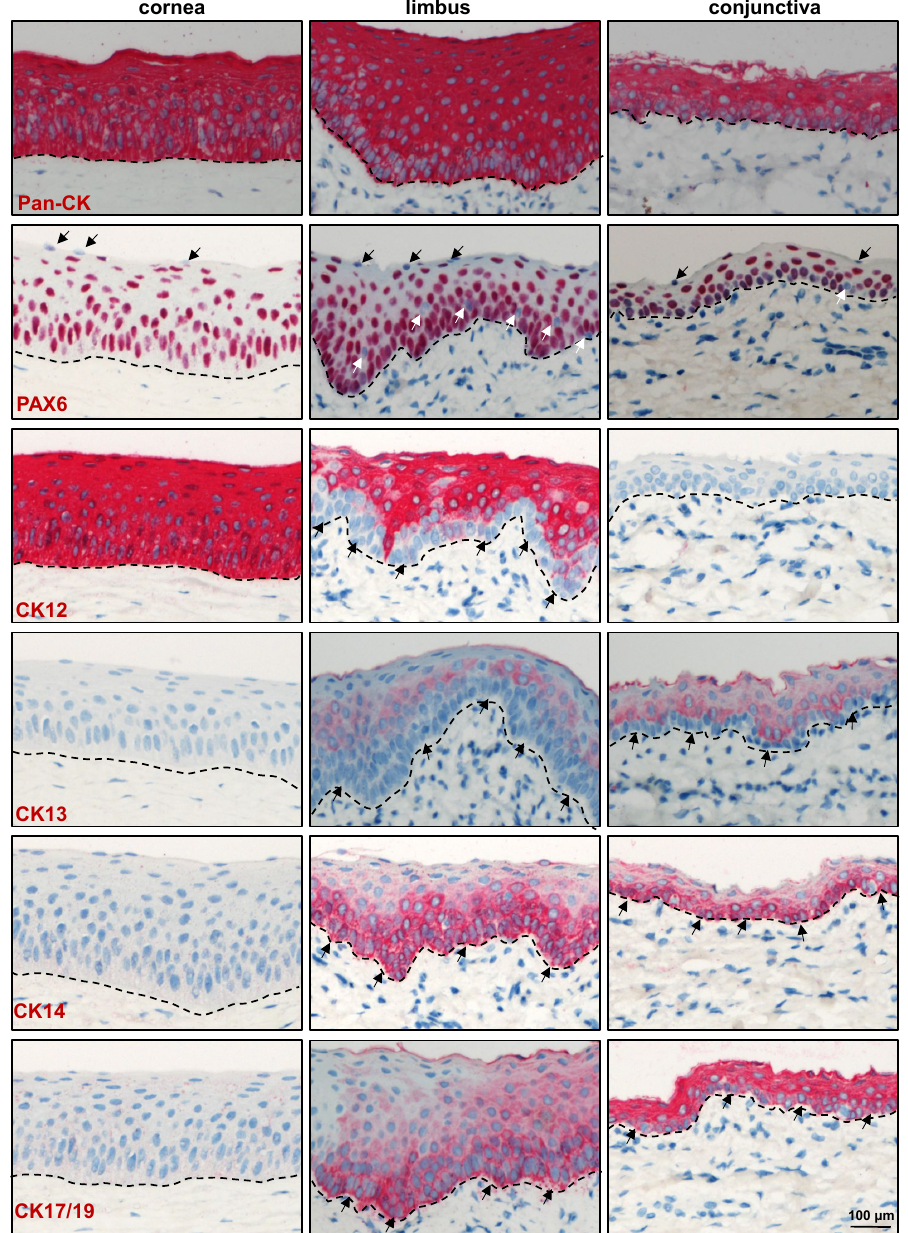
Figure 2. Immunohistochemical analysis of epithelial-related markers: Immunohistochemical staining of paraffin sections showing the expression of epithelial keratins (pan-CK) in all epithelial layers of the cornea, limbus, and conjunctiva (red); PAX6 expression in all layers of corneal epithelium and in nearly all epithelial cell layers of limbus and conjunctiva except for some basal cells (white arrows) and superficial epithelial cells (black arrows); cytokeratin (CK) 12 expression in all layers of the corneal epithelium, but only in suprabasal cell layers of limbal epithelium (arrows); CK13 expression in the suprabasal cell layers of both limbal and conjunctival epithelium and negative in the basal layers (arrows); CK14 expression in the basal layers of the limbal and conjunctival epithelia (arrows) but negative in the corneal epithelium; and CK17/19 expression in basal layers of the limbal epithelium (arrows) and in all layers of the conjunctival epithelium (arrows); dashed line represents basement membrane.